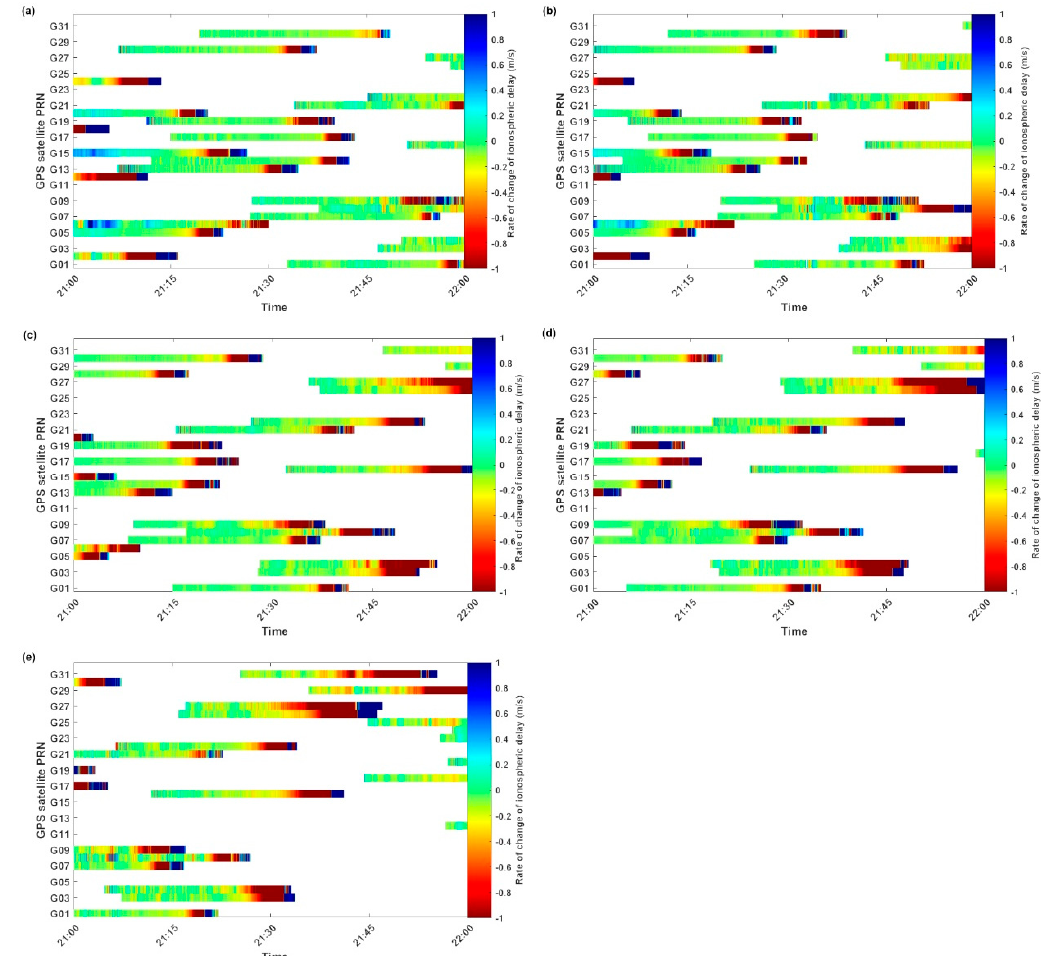
Figure 7. Ionospheric delay rate of Sat − 2 (( a – e ) are DOY 138 ~ 142